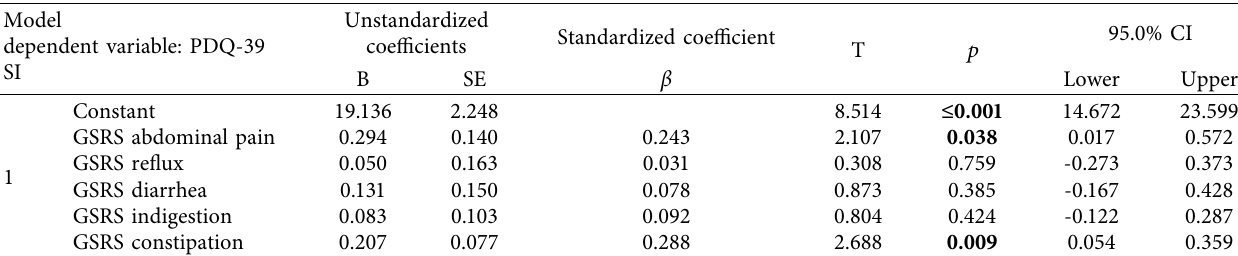
Table 8: Regression coefficients of the general linear model for the life quality dependence PDQ-39 on GSRS domain